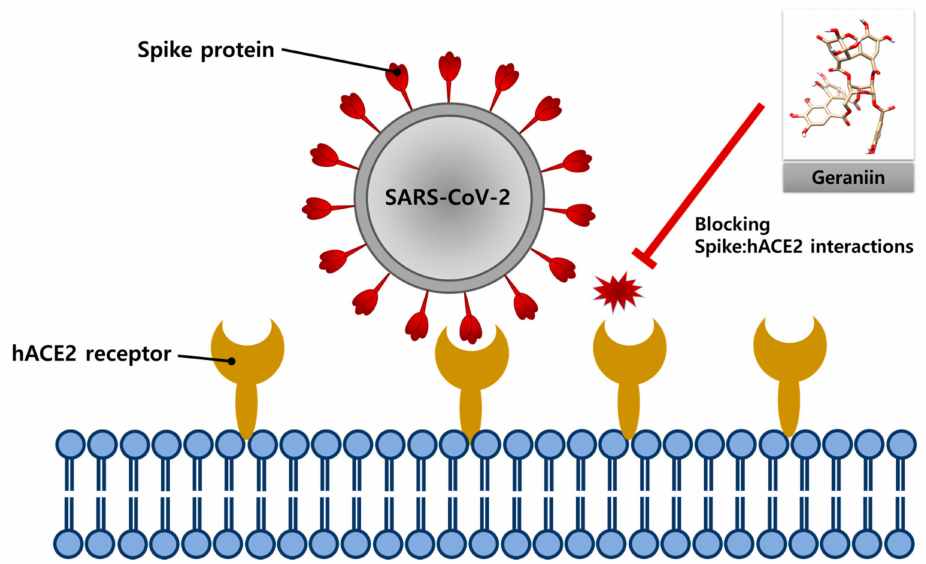
Figure 4. The diagram of the blockade of the SARS-CoV-2 spike protein: hACE2 receptor interactions by